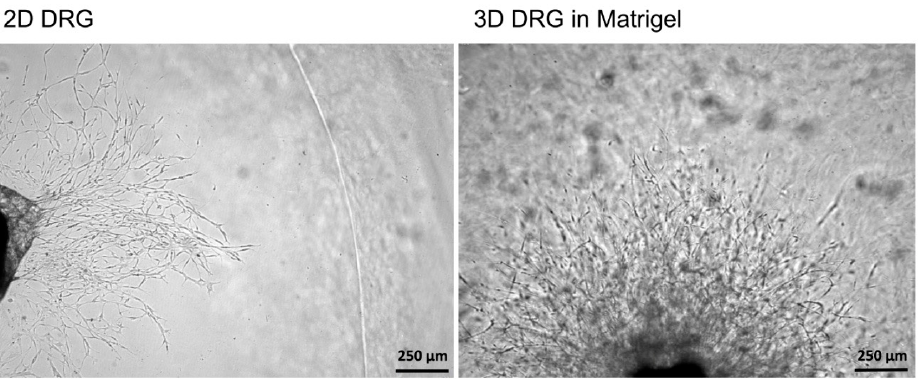
Figure 4. A comparison of 2D and 3D models of DRG in Matrigel ex vivo. In 2D culturing conditions, cells migrating from the DRG were noted, however, no neurites growing from DRGs were detected. In 3D cultures, cell migration was accompanied by the outgrowing